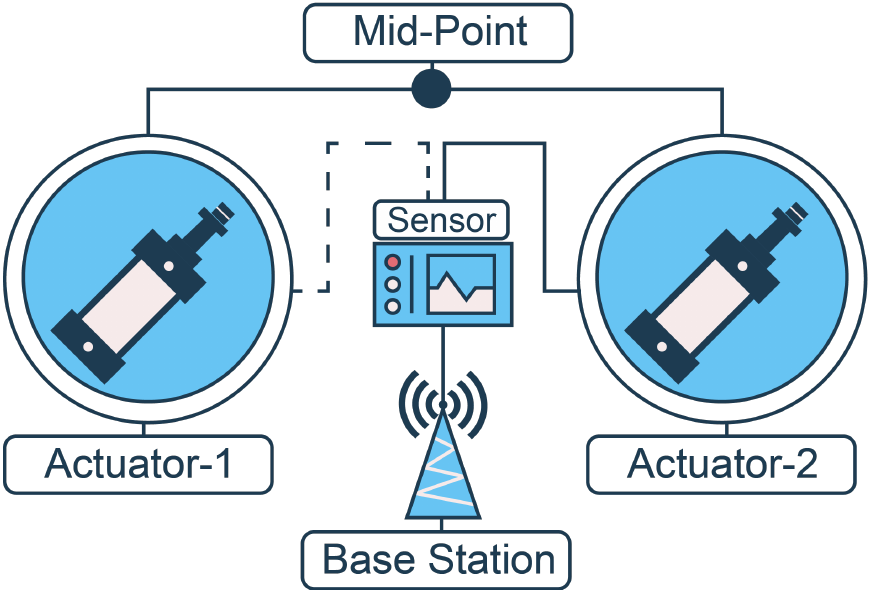
Figure 3. Average midpoint of the optimal